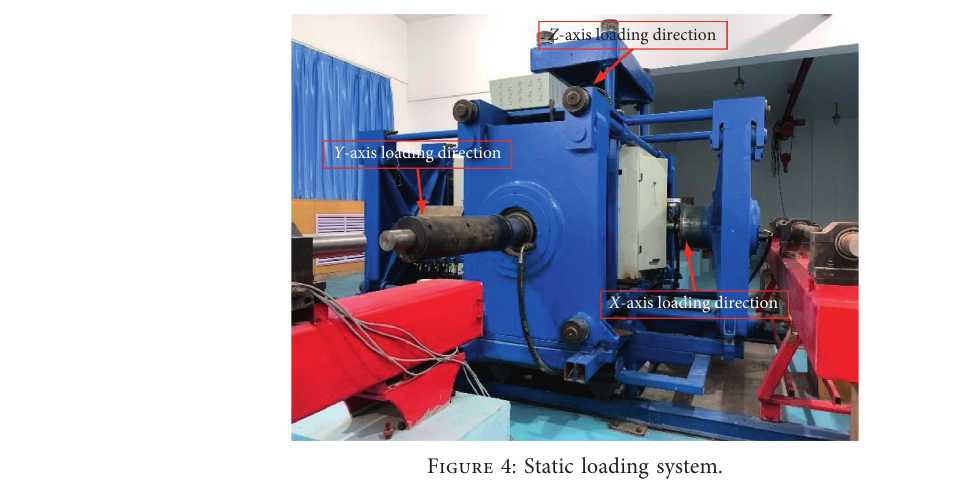
Figure 4: Static loading system.